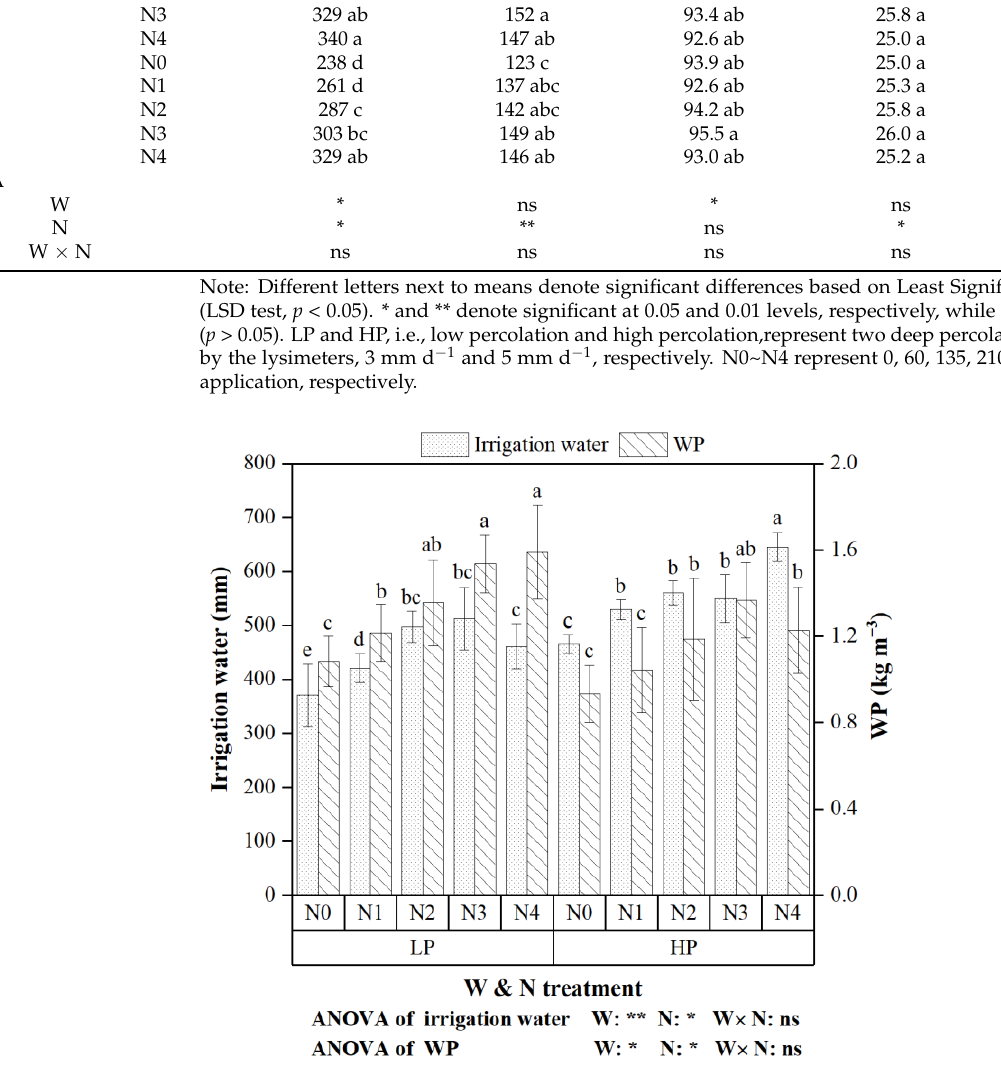
Figure 5. Irrigation water and total water productivity ( WP ) under various water and N treatments. Different letters next to means denote significant differences based on Least Significant Difference test (LSD test, p < 0.05). * and ** denote significant at 0.05 and 0.01 levels, respectively, while ns is non-significant ( p > 0.05). LP and HP, i.e., low percolation and high percolation, represent two deep percolation rates controlled by the lysimeters, 3 mm d −1 and 5 mm d −1 , respectively. N0~N4 represent 0, 60, 135, 210 and 285 kg N ha −1 application, respectively.